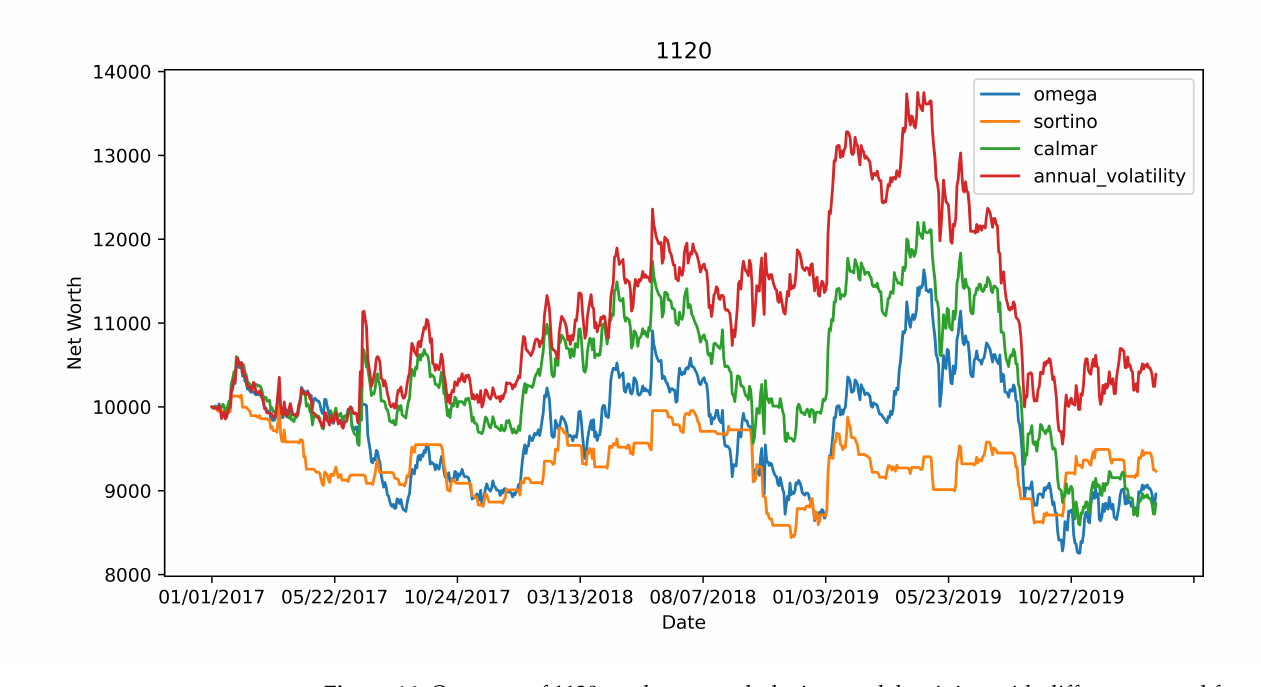
Figure 16. Outcome of 1120 stock net worth during model training with different reward functions (Initial portfolio value $10,000).